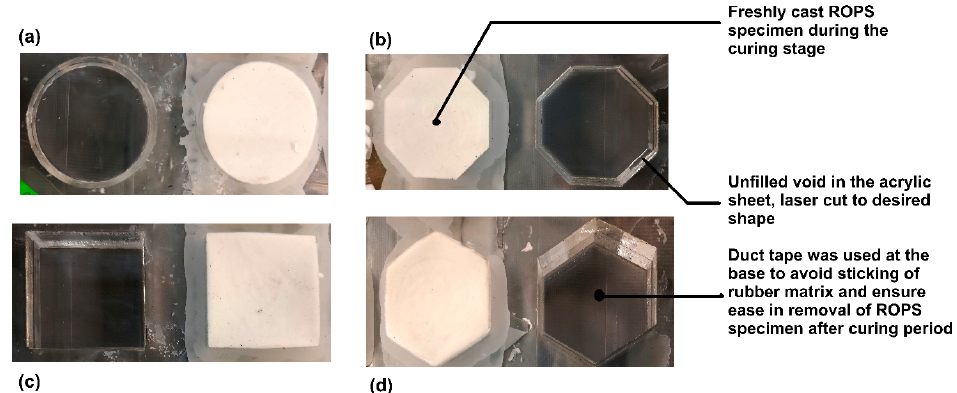
Figure 1. Images showing the moulds used for casting the ROPS specimens in laboratory: ( a ) circular; ( b ) square; ( c ) hexagon; ( d ) octagon.